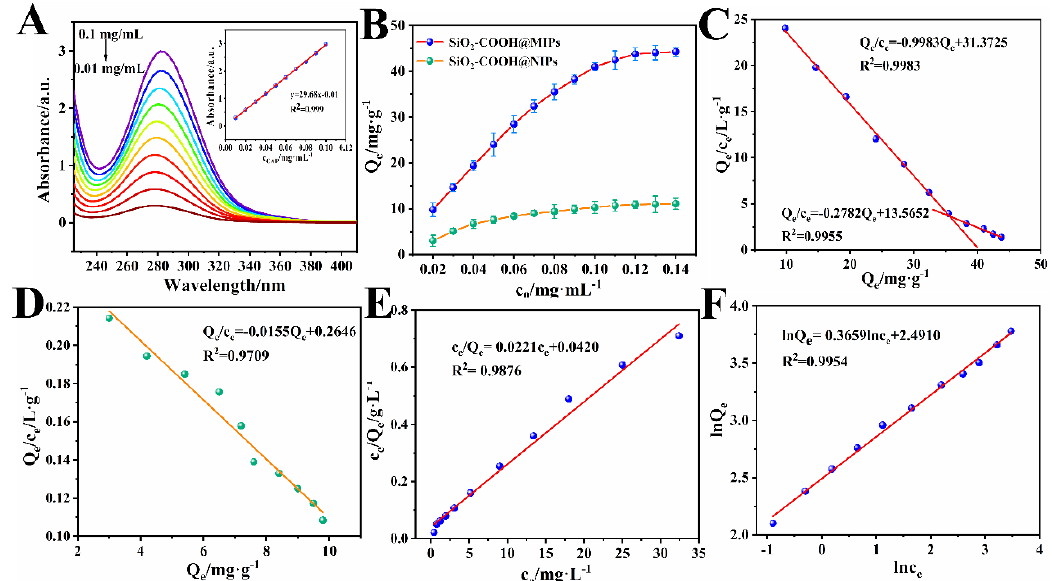
Figure 4. ( A ) UV absorbance curves of CAP solutions with different concentrations (0.01 mg/mL – 0.1 mg/mL) (illustration: the standard curve obtained by fitting different CAP concentrations with their corresponding absorbance values). ( B ) Adsorption isotherms for the adsorption of different concentrations of CAP by SiO 2 -COOH@MIPs and SiO 2 -COOH@NIPs. Scatchard model fitting curves of adsorption isotherms of SiO 2 -COOH@MIPs ( C ) and SiO 2 -COOH@NIPs ( D ). The adsorption isotherm fitting curves of SiO 2 -COOH@MIPs (Langmuir adsorption model ( E ); Freundlich adsorption model ( F )) ( n = 3).